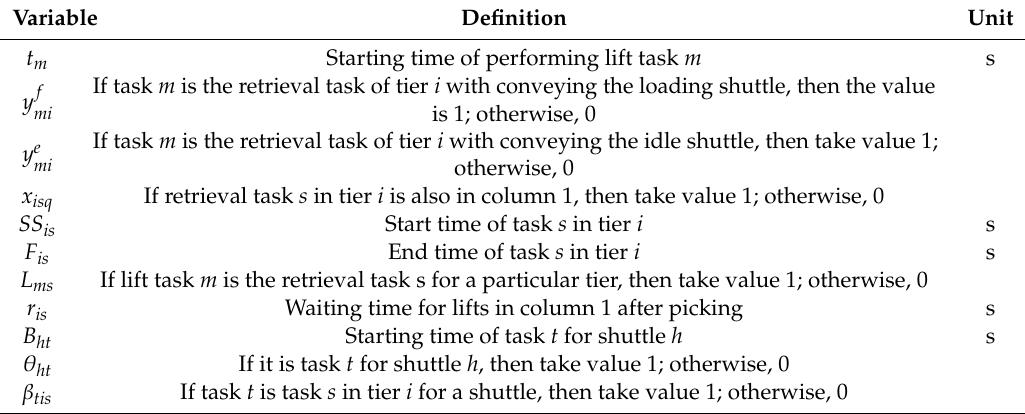
Table 3. Variables and